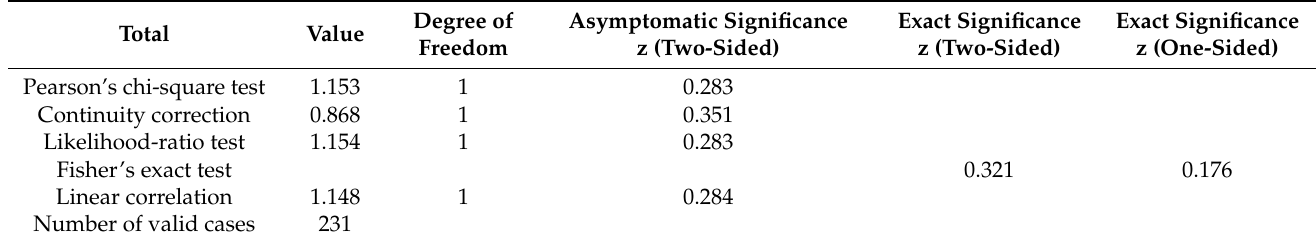
Table 2. Chi-square test (FT-IR dendrograms): Influence of animal species on the cluster formation of E. coli isolated from pigs ( n = 120) and chickens ( n = 120) from pasture